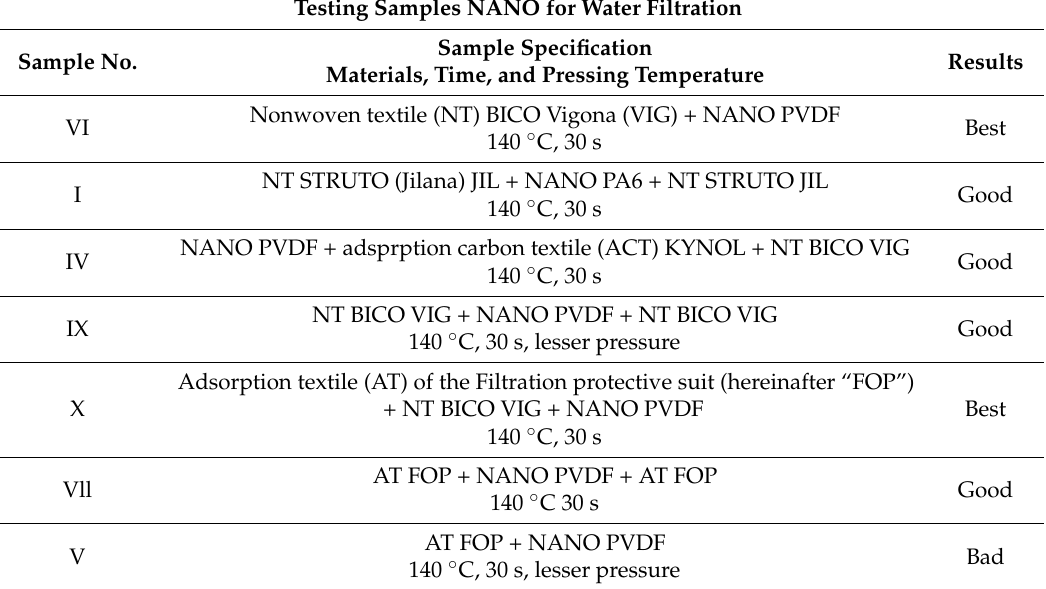
Table 2. Selected combinations of filtration sorptive layers and their final evaluation, in terms of the efficiency of capturing the particles from an aqueous solution.